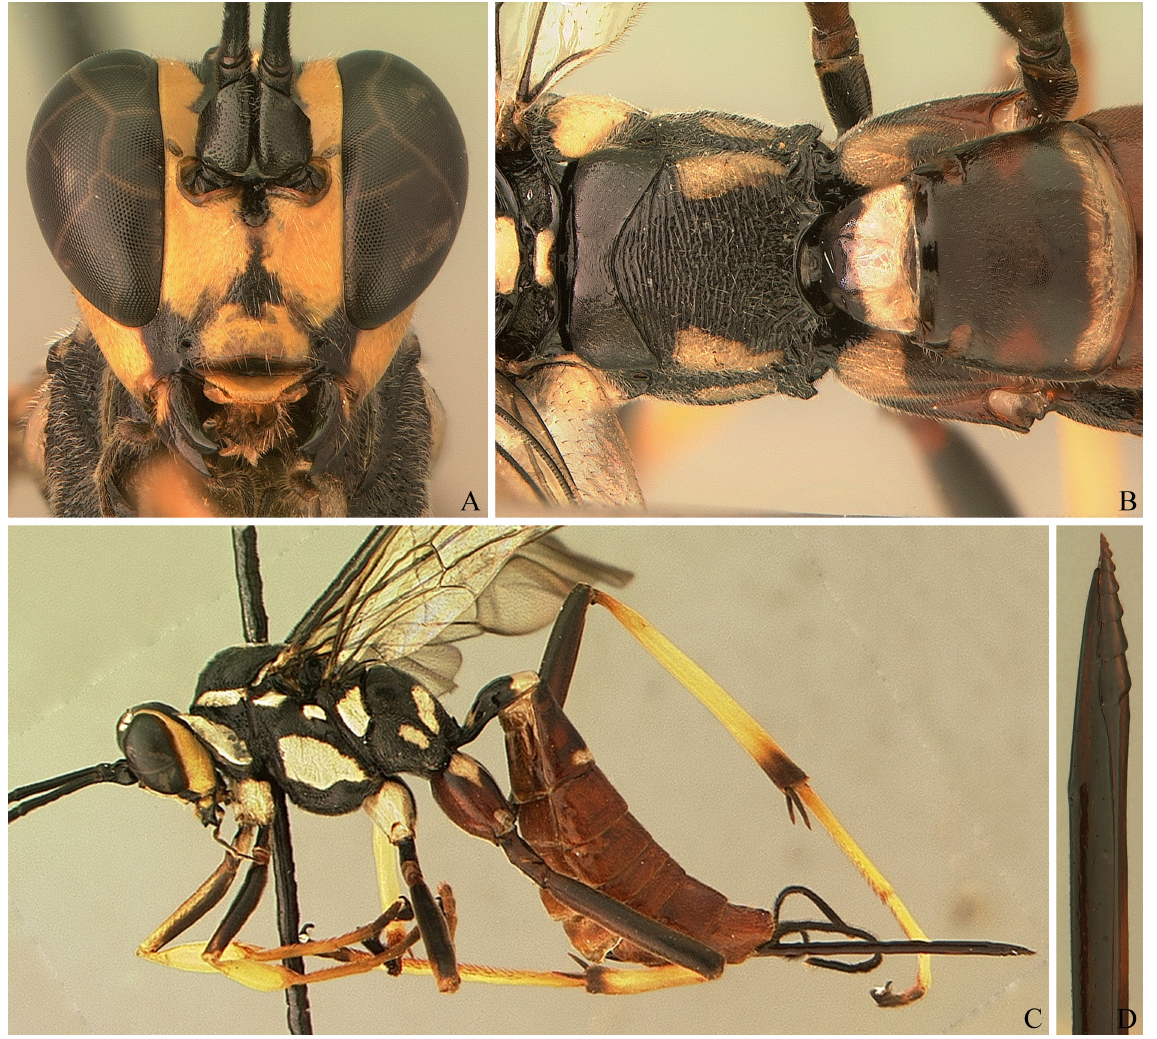
Fig. 9. Distictus commatus sp. nov., holotype (USUC) ♀. A . Head, frontal view. B . Propodeum + first two tergites, dorsal view. C . Habitus D . Apex of ovipositor,